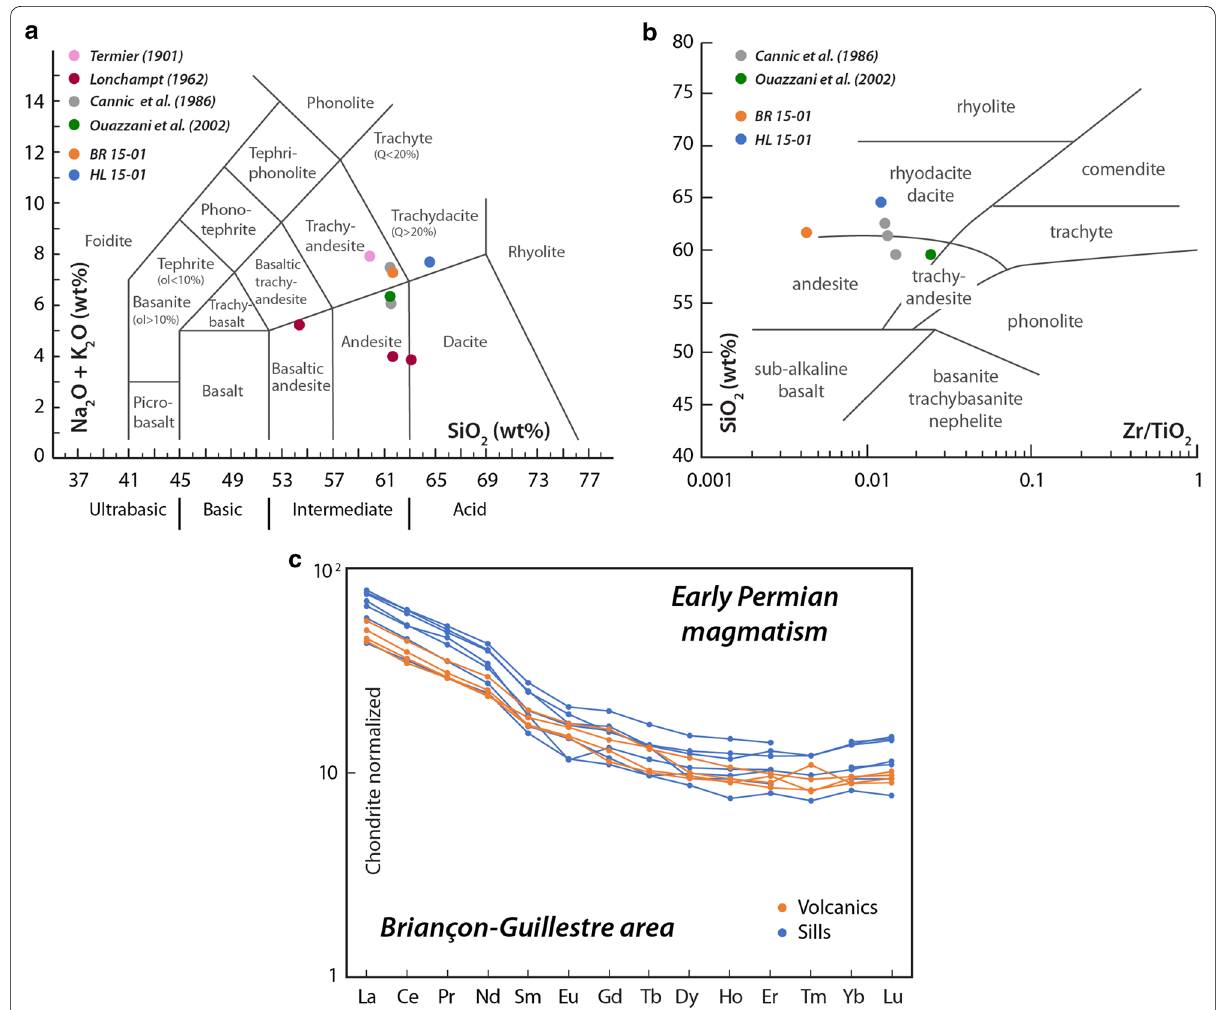
Fig. 6 a Bulk chemistry of the Guil volcanics (sample BR 15-01) and of the Combarine sill (sample HL 15-01) reported in the TAS diagram (Le Maître 2002) and in the SiO 2 –Zr/TiO 2 plot (Winchester and Floyd 1976). All available analyses have been reported on an anhydrous basis. b REE patterns (normalized to the chondrites according to McDonough and Sun 1995) of the Guil volcanics and of the Combarine sill compared with